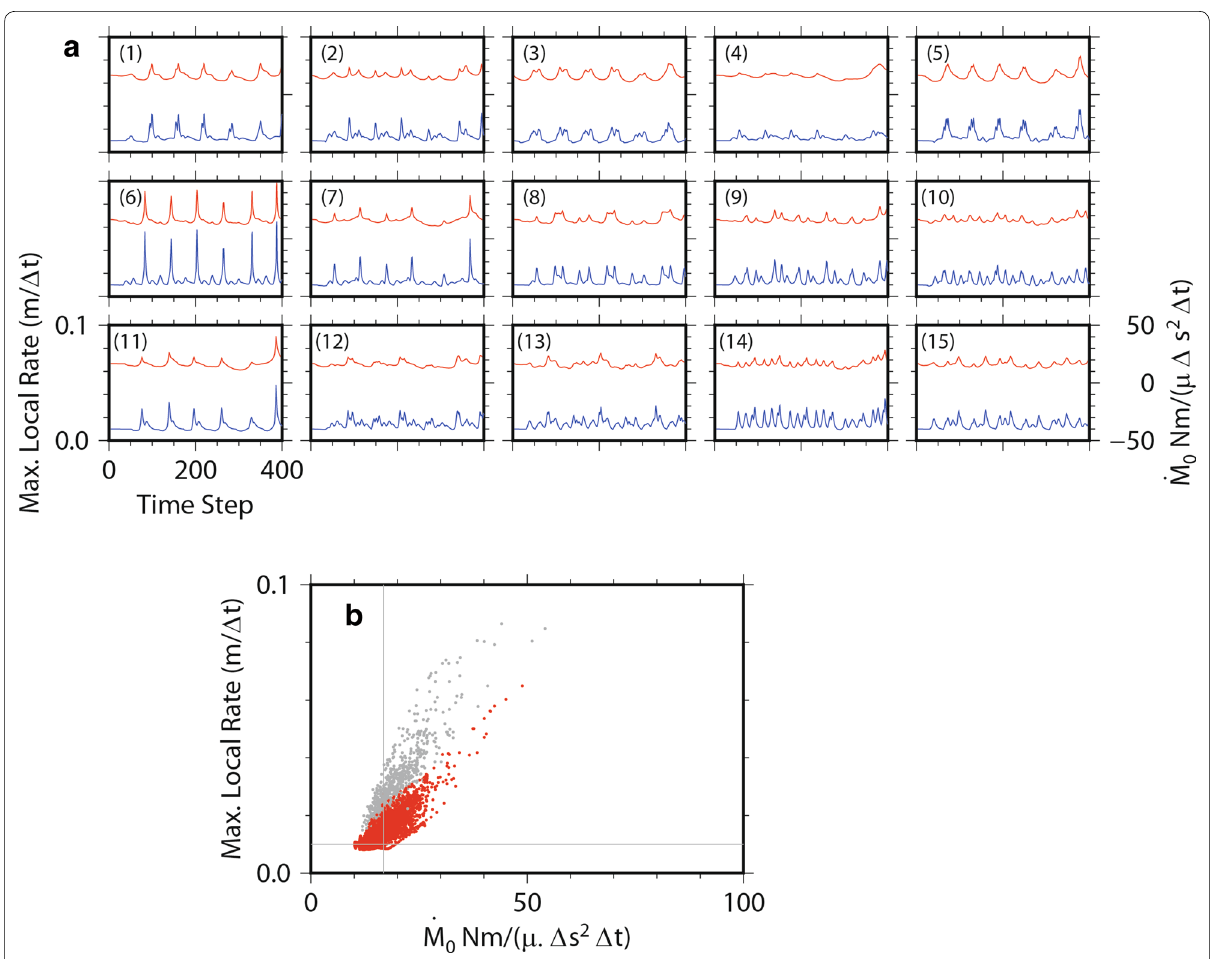
Fig. 13 Temporal evolution of all 15 simulations from Fig. 11. a The maximum slip rate at each time step is in blue ( left axis ) and the seismic moment release rate from the whole area is in red ( right axis ). b Relationship between the above two values from all 15 simulations, denoted by red points . Gray points represent the relationship for the case that includes the smallest patches k = 4 , from Fig.